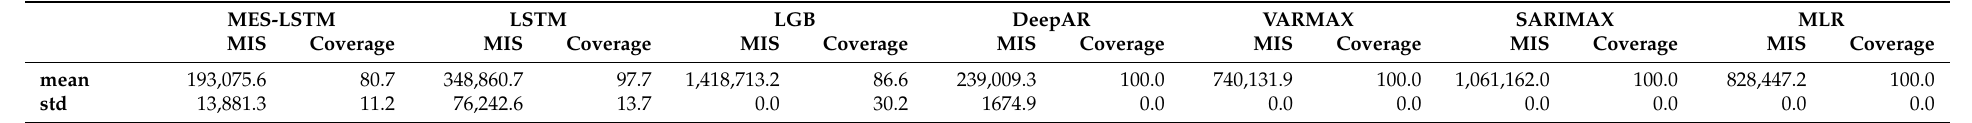
Table 10. Prediction Interval Accuracy Distribution for All Trials for total cases in South Africa ( α = 0.05).